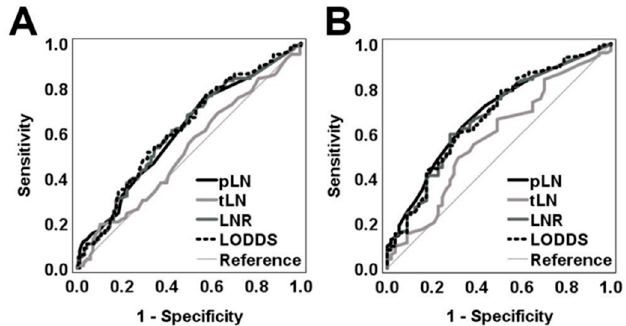
Figure 2. ROC analysis of various LN classification systems. ROC curves were generated for LNR, LODDS, pLN (positive lymph nodes), and tLN (total lymph nodes) as categorical variables to predict ( A ) 1-year OS and ( B ) 3-year OS.